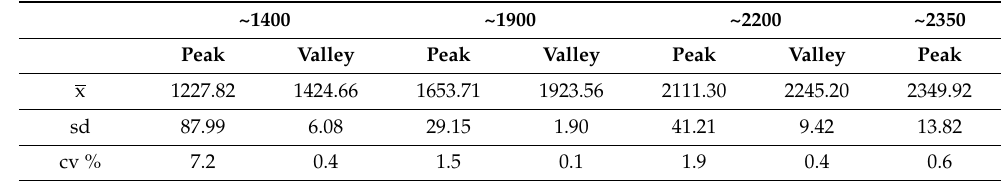
Table 1. Statistical parameters of the most prominent absorption patterns in the SWIR range. ~1400 ~1900 ~2200 ~2350